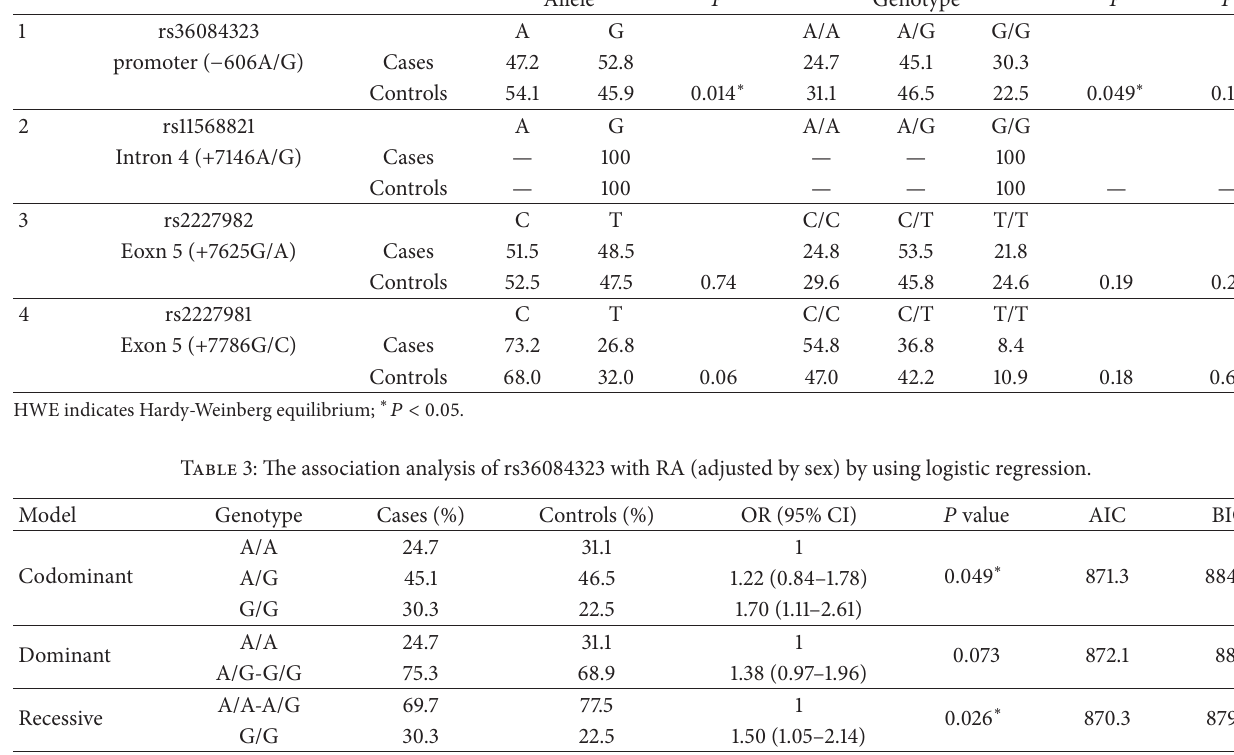
Table 2: The 4 SNPs of PDCD-1 gene investigated in the cases ( 𝑛 = 320 ) and controls ( 𝑛 = 309 ). SNP dbSNP ID and position